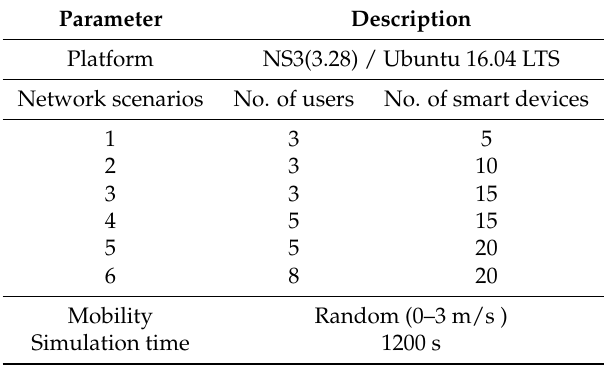
Table 4. Simulation